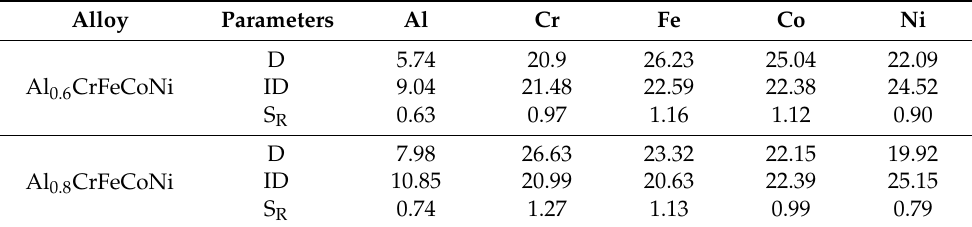
Table 3. Composition analysis results in D and ID areas and S R values for Al 0.6 CrFeCoNi and Al 0.8 CrFeCoNi alloys.